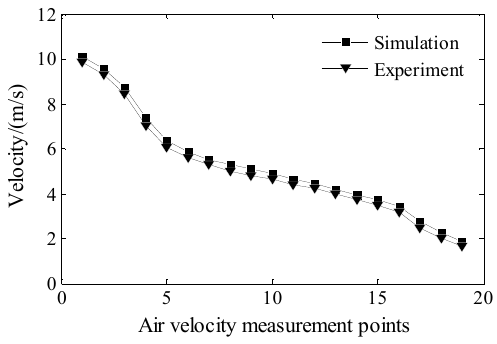
Figure 10. Comparison of air velocity in simulation and experiment along the path 11.